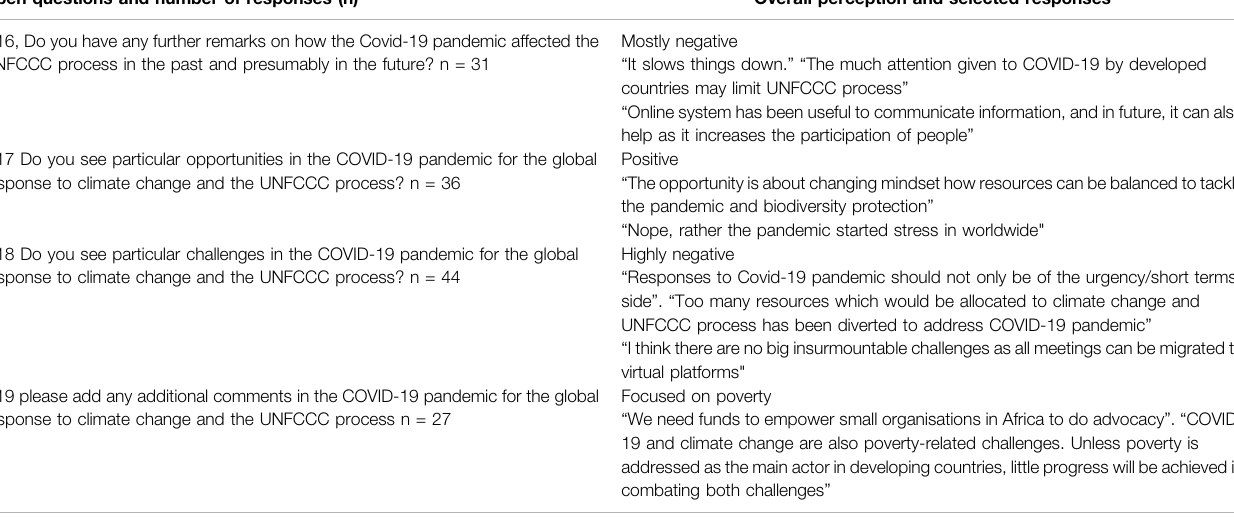
TABLE 5 | Responses from open